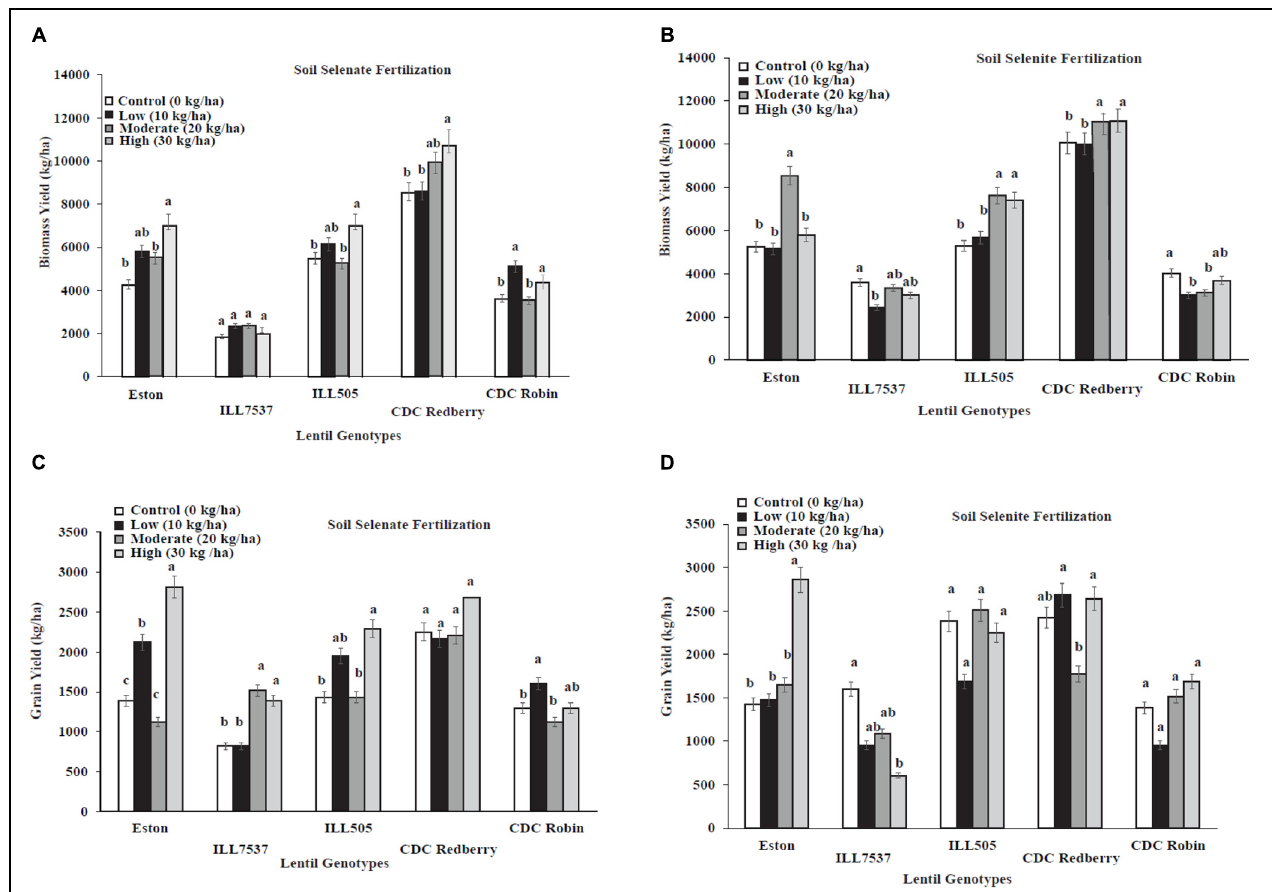
FIGURE 1 | Genotypic variation of lentil biomass yield (A,B) and grain yield (C,D) with response to soil application of selenate and selenite fertilizer at different rates. Each genotype (bars) for each Se rate followed by different letters are significantly different at P <